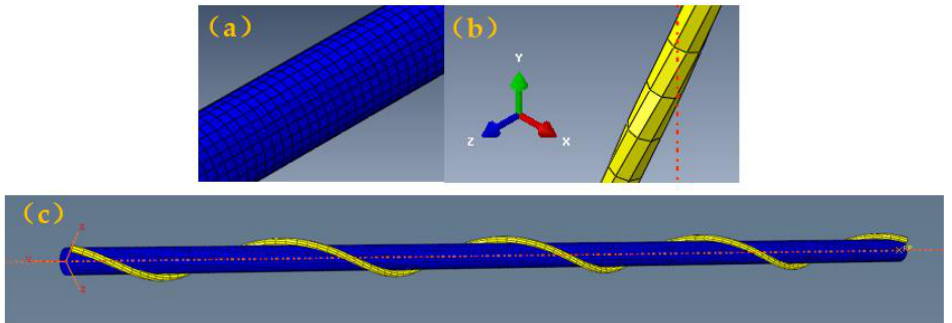
Figure 2. The meshes for the helical auxetic yarn: ( a ) core filament; ( b ) wrap filament; ( c ) complex yarn.